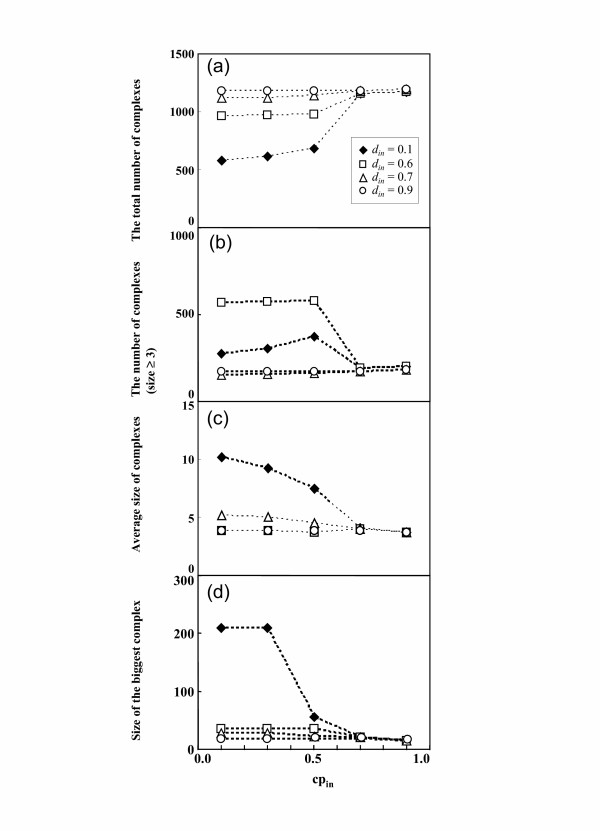
The effect of cpin on clustering. Twenty sets of non-overlapping clusters are generated from the yeast PPI using cpin = 0.1, 0.3, 0.5, 0.7, 0.9 and for each of these values of cpin using din = 0.1, 0.6, 0.7, 0.9. We then calculated and plotted (a) the total number of clusters, (b) the number of clusters of size ≥ 3, (c) the average size of the clusters of size ≥ 3, and (d) the size of the biggest cluster with respect to cpin.